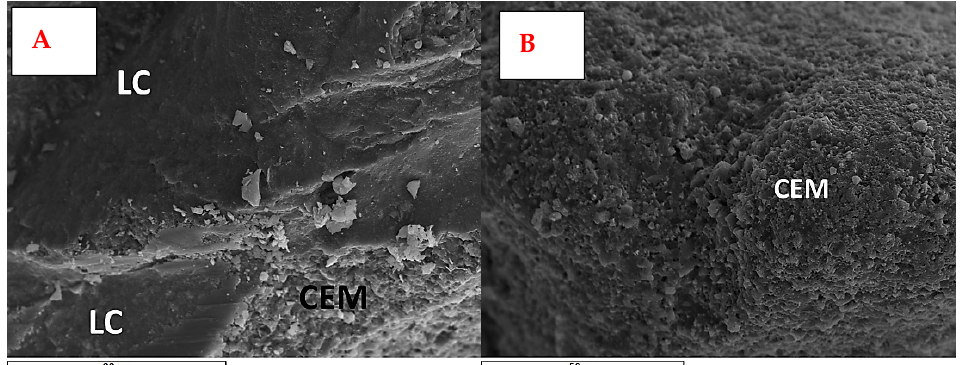
Figure 13. SE images of fracture surfaces of: ( A ): KAN 1 sample; cement binds siliceous clastic grains; ( B ): Homogeneous micritic cement envelopes clastic material in LY1 groundmass. CEM: cement; LC: lithoclast.